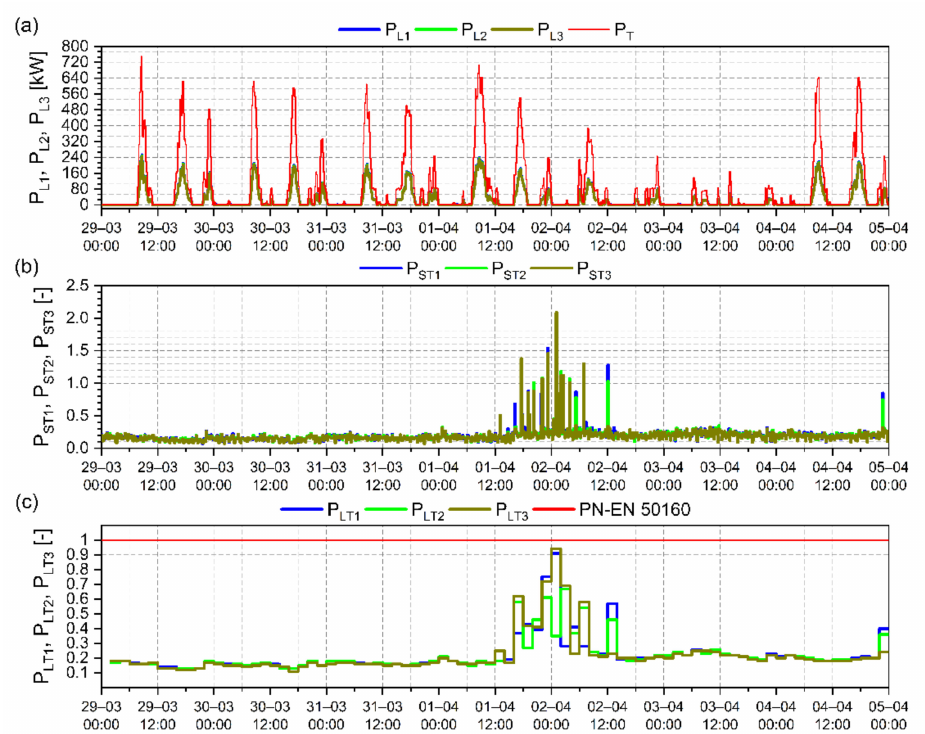
Figure 14. ( a ) Total active power demand profile (10 min averaged); ( b ) short-term flicker perceptibil- ity; ( c ) long-term flicker perceptibility during the measurement period. Table 3. Values of short-term and long-term flicker perceptibility (one-week measurement period). N total Mean Minimum Median Maximum P95 P ST1 1008 0.19 0.07 0.18 2.05 0.29 P ST2 1008 0.19 0.07 0.18 1.03 0.28 P ST3 1008 0.19 0.07 0.17 P LT1 84 0.22 0.11 0.18 0.91 0.41 P LT2 84 0.22 0.13 0.18 0.67 0.46 P LT3 84 0.22 0.11 0.18 0.94